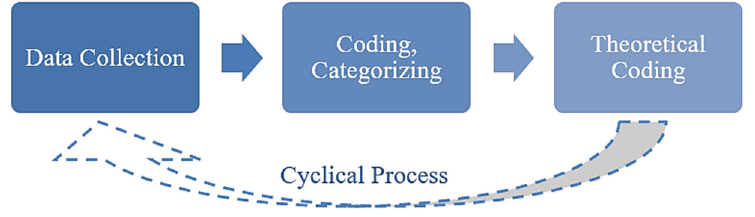
Figure 5. Scheme of the grounded theory research methodology used in this study.